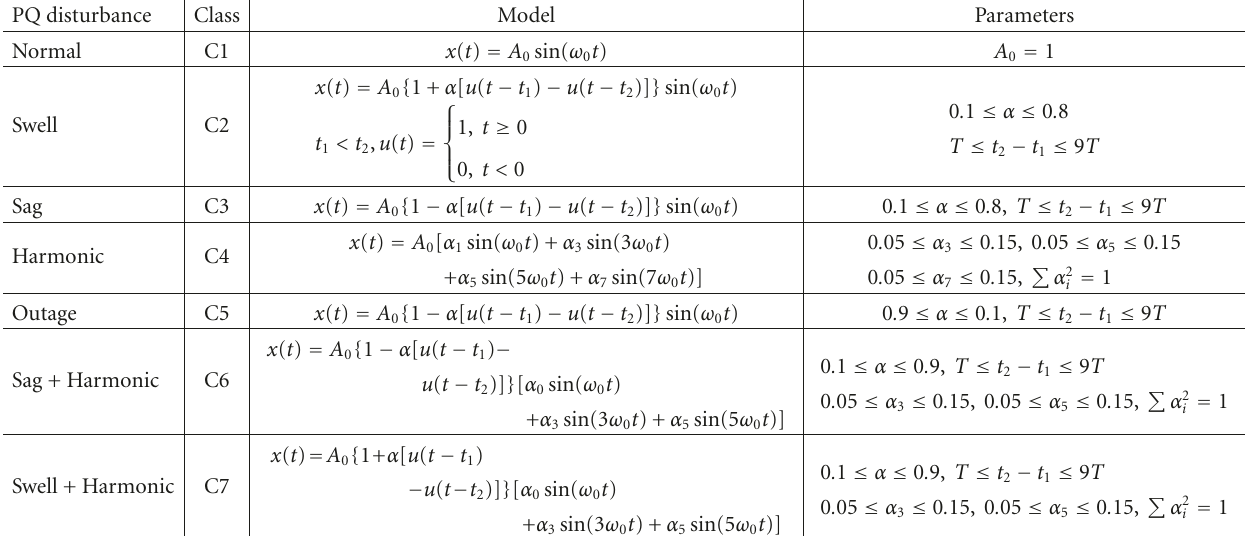
Table 5: Power quality disturbance models following [3].